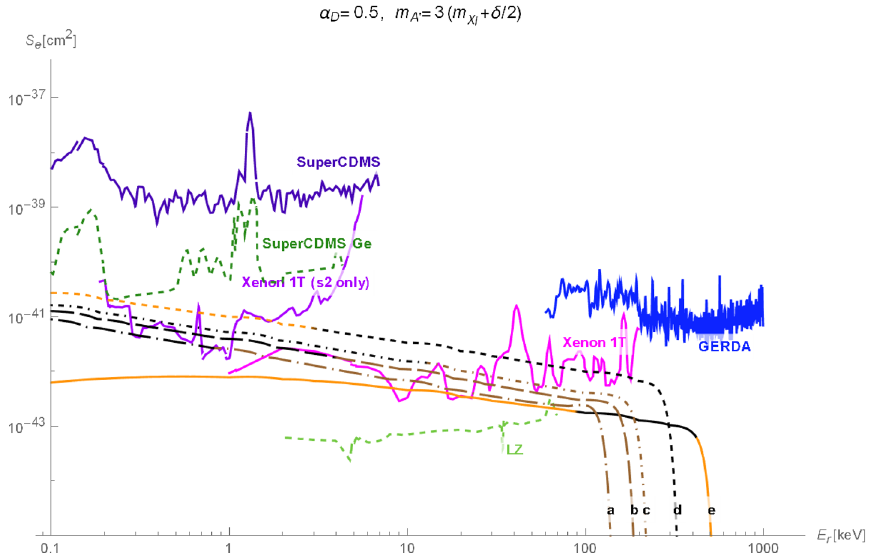
Figure 11 . Sensitivity plot for electron recoil searches. The black/brown/orange lines corresponds to the excited DM fraction at the detector times the DM-electron cross section per GeV DM mass for a thermal target. The lines labeled a, b, c, d, e correspond to m = 0 . 002 GeV, 0 . 005 GeV, 0 . 01 GeV, χ l 0 . 1 GeV, and 1 GeV respectively. The thermal target is excluded by the CMB when the line is orange. When it turns brown the semi-elastic process of the subsection 4.2.3 becomes relevant. The solid color lines show the sensitivity limits for Xenon1T, Xenon1T s2-only, SuperCDMS, and GERDA, obtained by recasting these experiments’ bounds on another line-like signal (dark-photon DM), as described in the previous section. The dashed lines show the projections for SuperCDMS with a germanium target and Lux-Zeplin, obtained by the same method from experimental projections. Analogous plots for additional dark-sector benchmarks are shown in figure